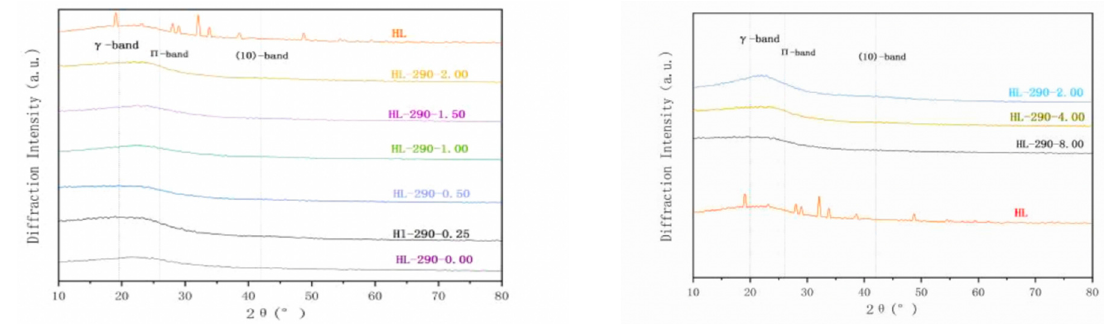
Figure 3. X-ray spectra of lignin and its hydrothermal carbon at different holding times.